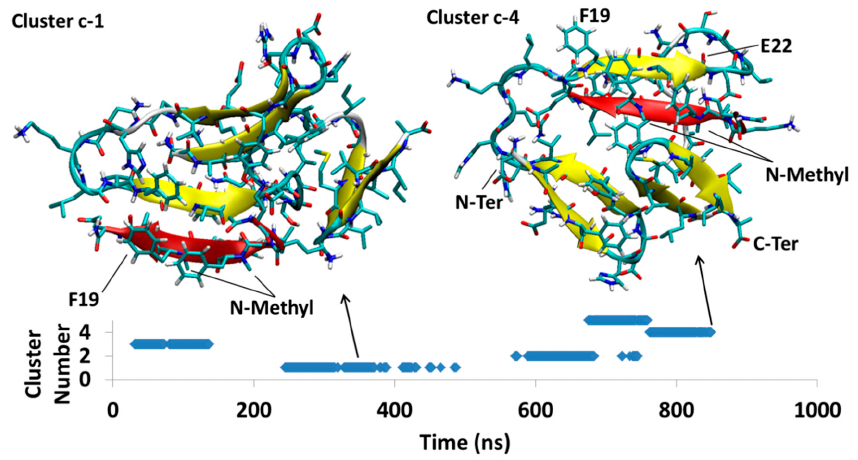
Figure 7. A β 42B -SGB1-c; cluster Bc1 with the highest population of similar conformations and Bc4, the last significant cluster in the trajectory are shown. The vertical axis is the cluster number count based on population, where cluster 1 has the highest population. The horizontal axis is simulation time in nanoseconds.